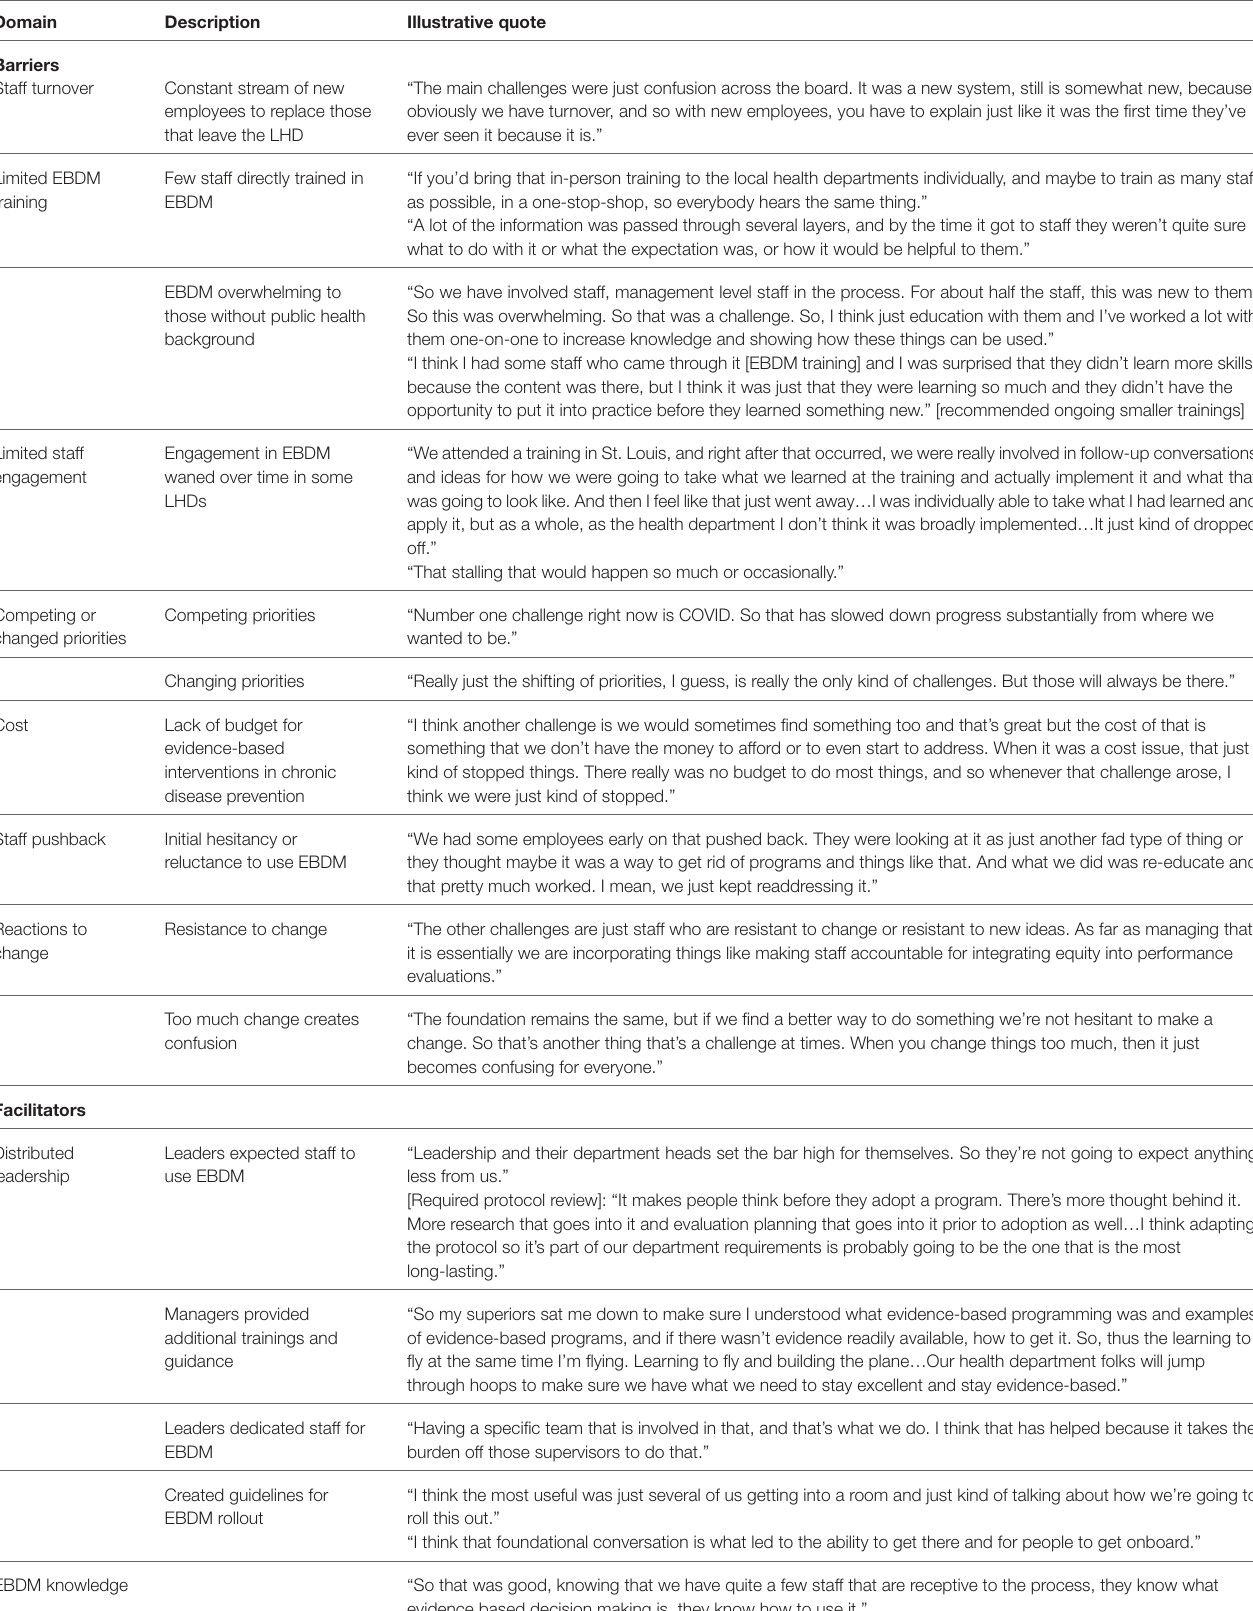
TABLE 5 | Barriers and facilitators to use of evidence-based decision making in local health